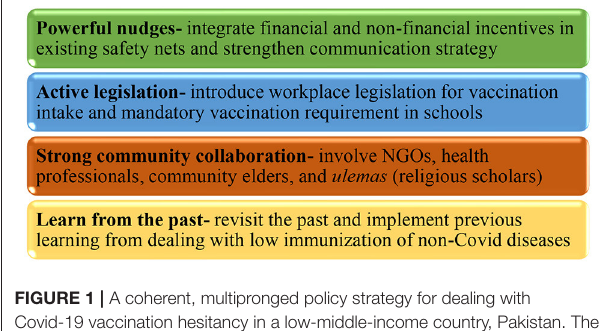
FIGURE 1 | A coherent, multipronged policy strategy for dealing with Covid-19 vaccination hesitancy in a low-middle-income country, Pakistan. The four suggestions presented in this commentary work together to increase vaccination rates in